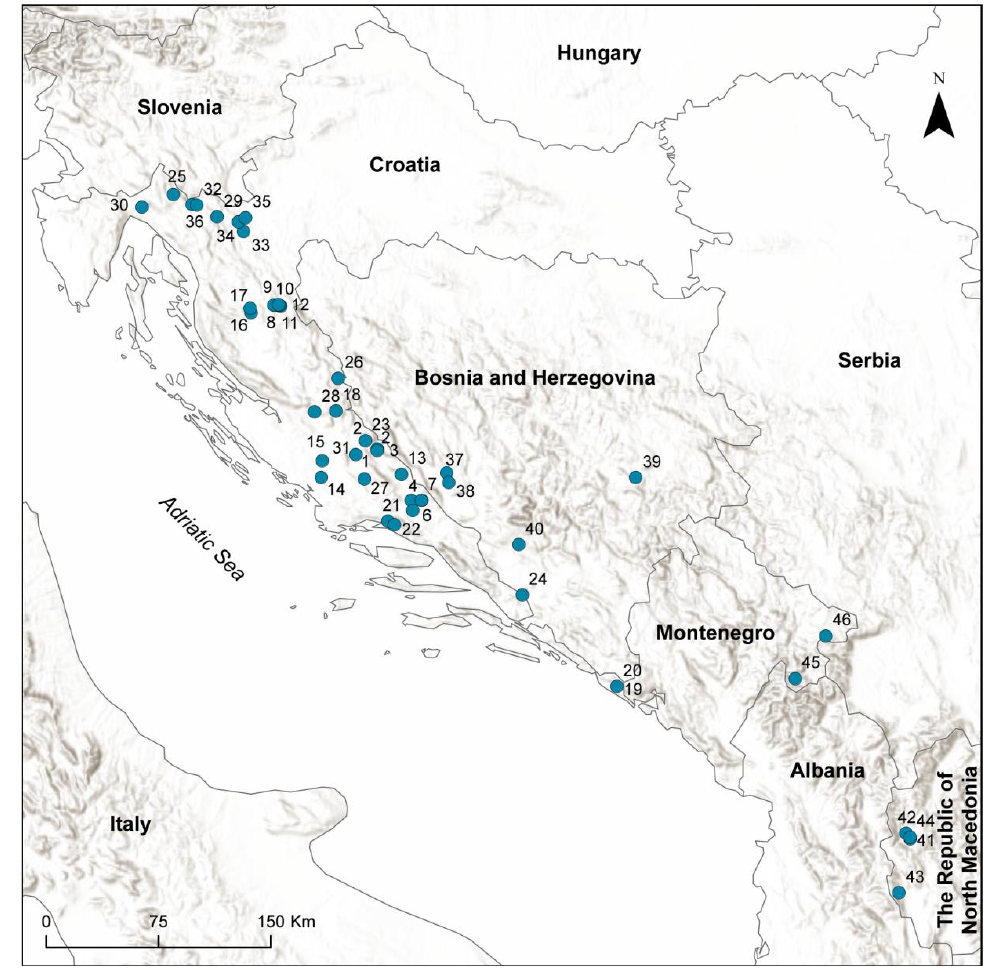
Figure 2. Distribution of E. bosnica (Zaitzev, 1908), in Southeastern Europe. Locality codes are the same as in Table 1. Table 1. Characteristics of sampling sites in Southeastern Europe, where E. bosnica (Zaitzev, 1908), was recorded from 2004 to 2019. Abbreviations: C, locality code; MWT, mean water